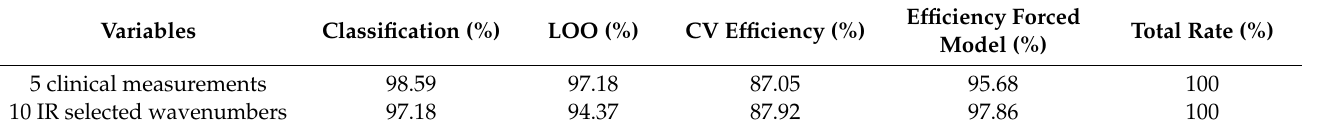
Table 5. The results of SIMCA class-modelling performance on clinical parameters and ten selected IR spectral